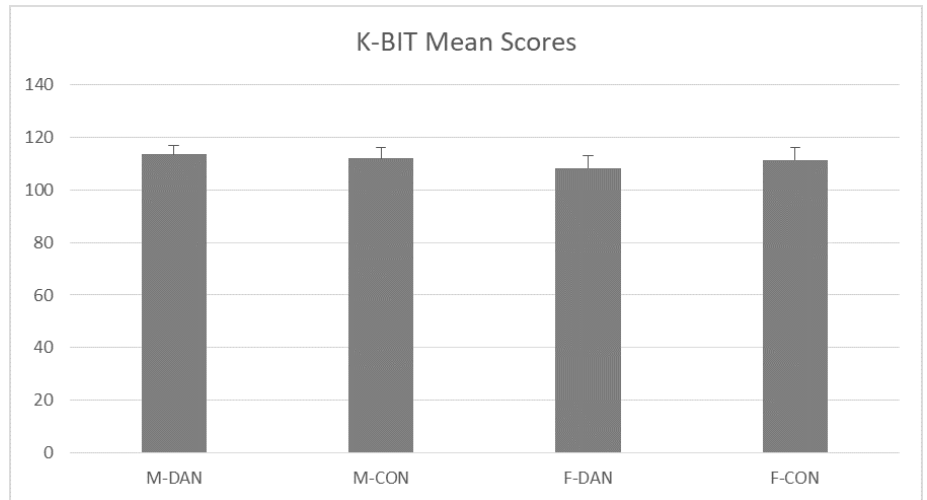
Figure 2. Kaufman Brief Intelligence Test (K-BIT) mean scores. Groups were very homogeneous in intelligence. No group differences emerged. Male dancing (M-DAN); female dancing (F-DAN); male control (M-CON); female control (F-CON). Mean + SEM.